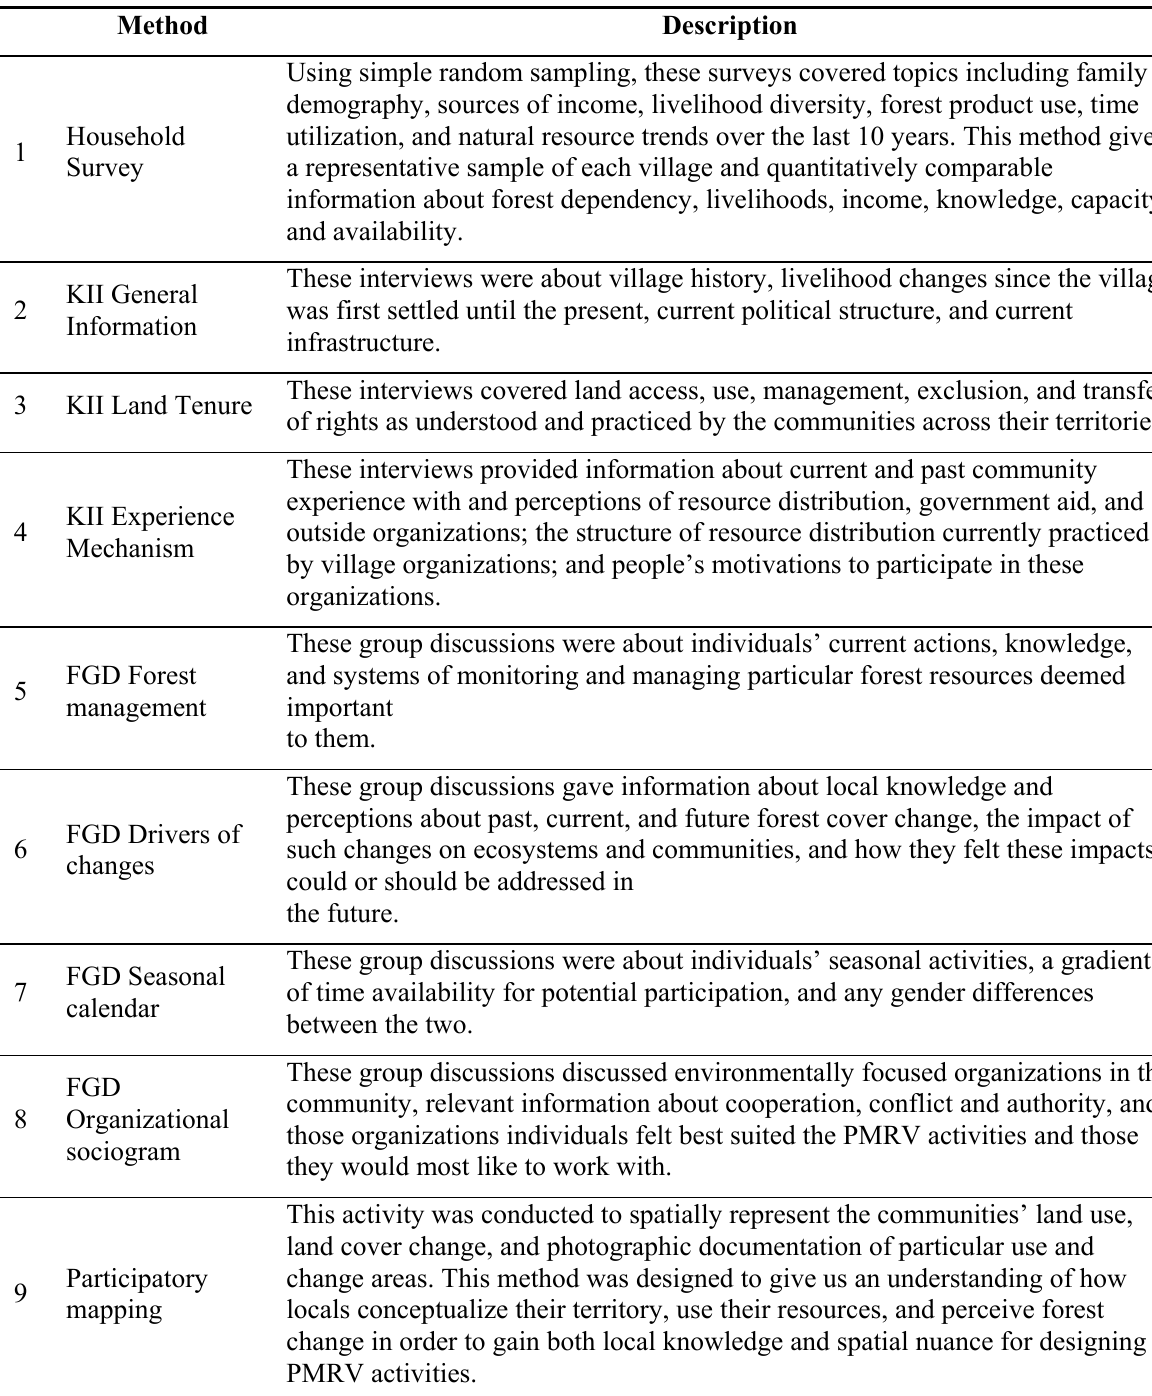
Table 6. Description of the research